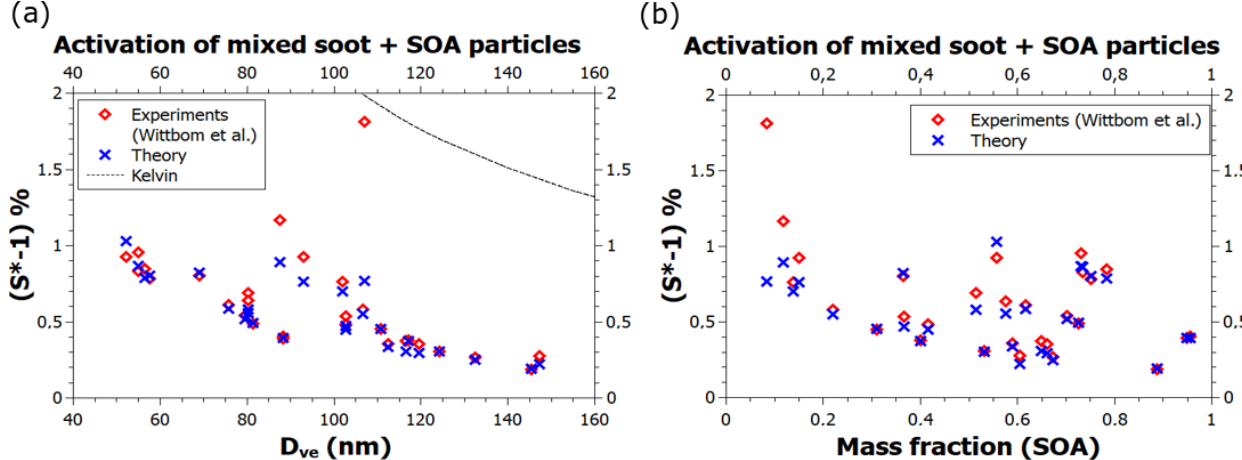
Figure 5. Experimental and theoretical critical supersaturations of water vapor on mixed soot particles containing BC and SOA as a function of (a) the volume equivalent diameter of dry particles and (b) the SOA mass fraction. The data are a subset of the data shown in Figs. 10 and 11 of Wittbom et al. (2014) and were identified by matching supersaturations (to a precision of < 0 . 01%) in the two